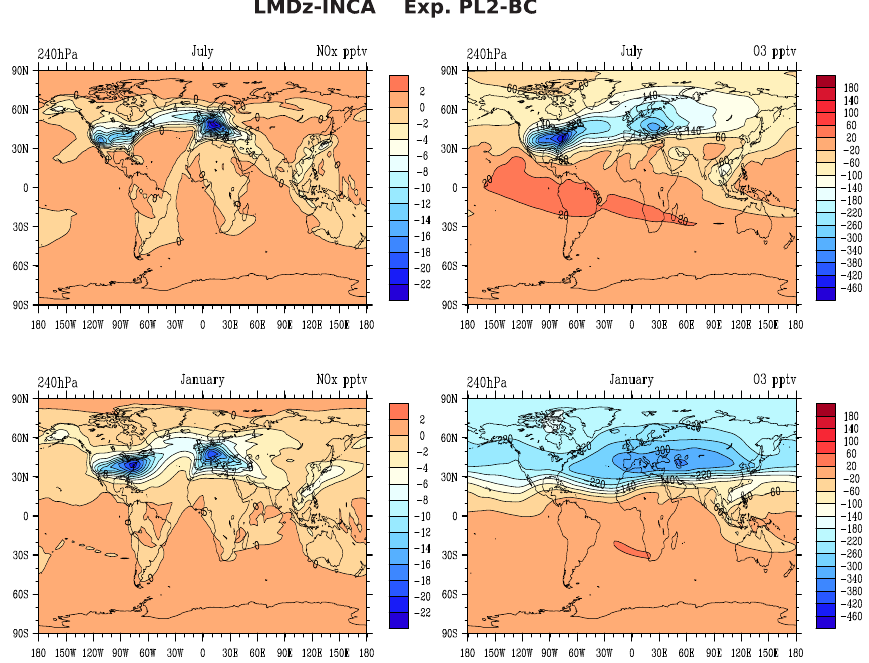
Fig. 22. LMDz-INCA model distributions of the NO x (left) and O 3 (right) variations at 240hPa in January (bottom panels) and July (upper panels) due to plume effects using the ERR method. Reprinted from Cariolle et al. (2009). An edited version of this paper was published by AGU. Copyright (2009) American Geophysical Union.